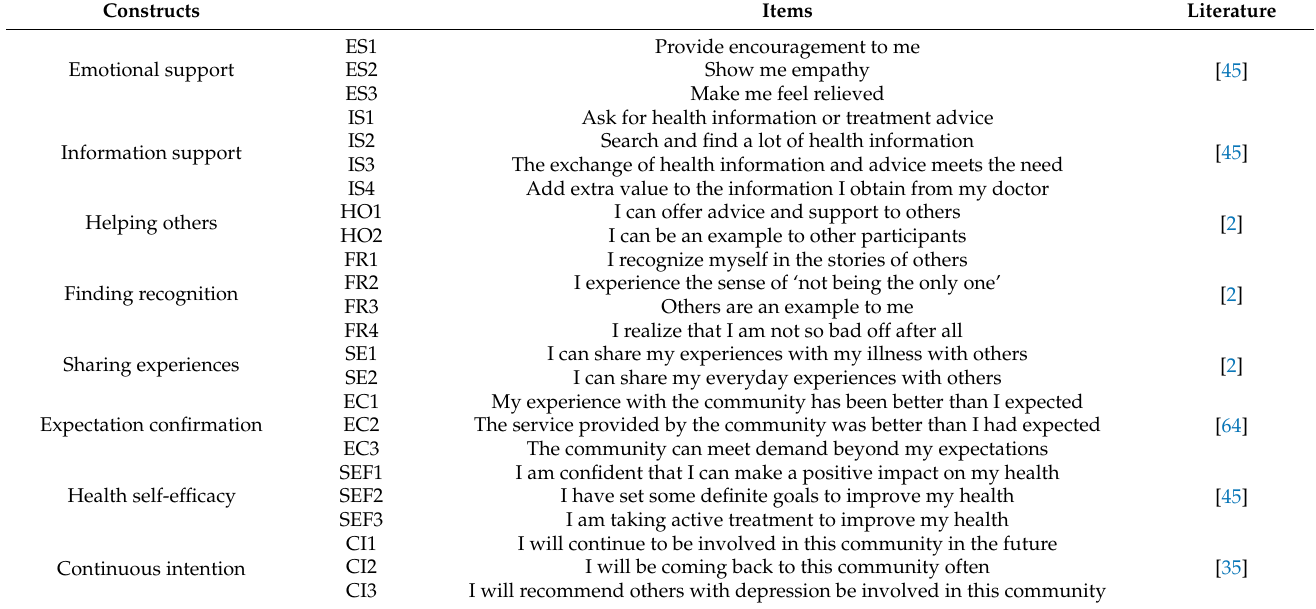
Table 2. The reliability and validity of the measurement model are analyzed, and then the hypothesis of the structural model ability is verified. Table 2. Constructs and items used in the questionnaire.